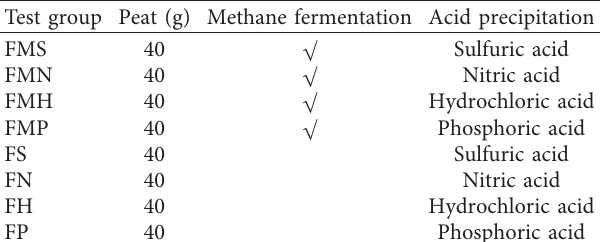
Table 1: Fulvic acid in different experiment groups.